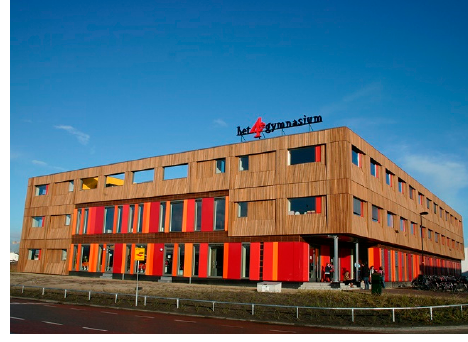
Figure 3. Temporary Het 4e Gymnasium School. Image: Future Proofing Schools.